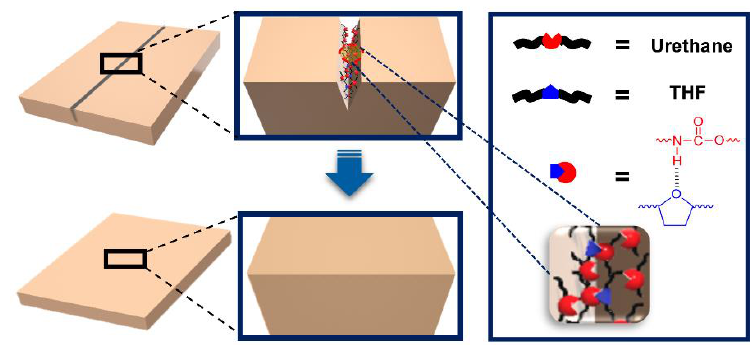
Figure 6. Schematic illustration of the self-healing mechanism of PUT. Red and blue represent the urethane group and heterocyclic group, respectively.